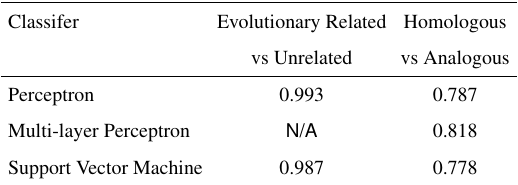
Table 2: Areas under the ROC